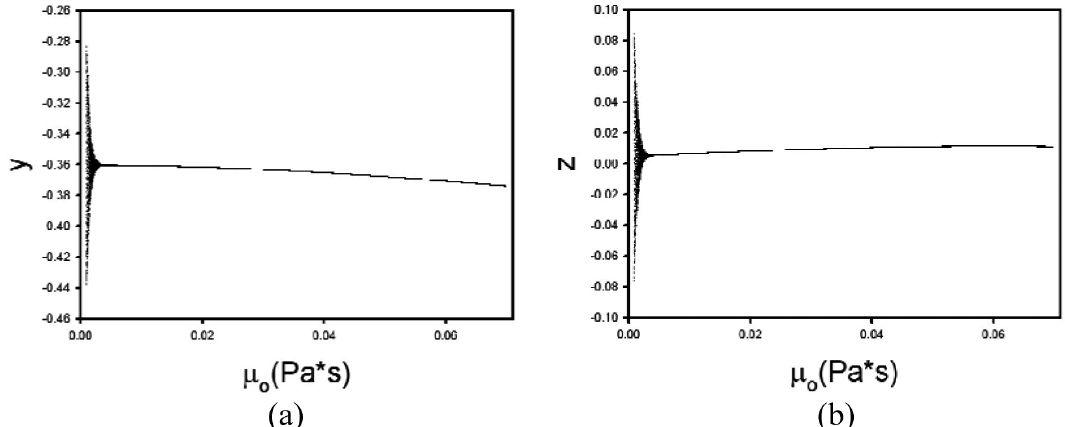
Fig. 19. The bifurcation diagram of displacements at the mid-span point versus oil viscosity. (a) y -displacement; (b) z -displacement. D = 0.25m, ω = 600 rad/s, γ m = 300 T 2 m/H, ρ s = 7800 kg/m 3 , E = 206 GPa, C = 0.001 D , C e = D /1600, L = 3 m, L b = D /4, e ¯ m = 0 . 0001 m, x a = 0.08, x b = 0.92.